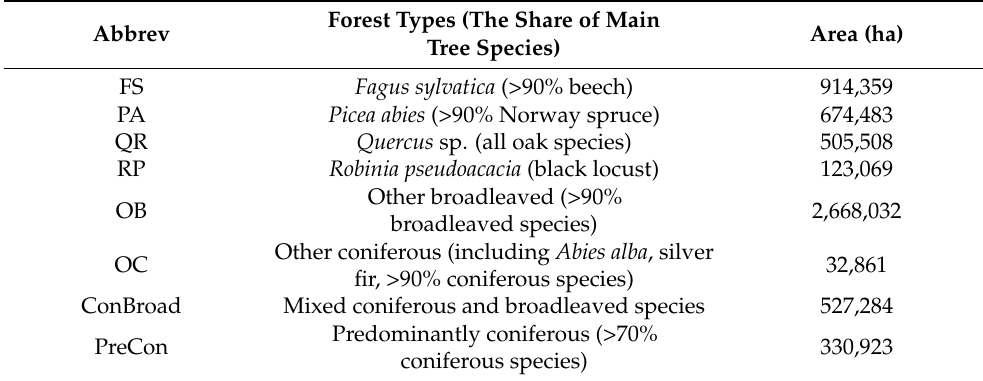
Table 1. The simulated forest types and the forest area (ha) in FAWS. In mixed forest, the proportion of each coniferous and broadleaved species is approximately